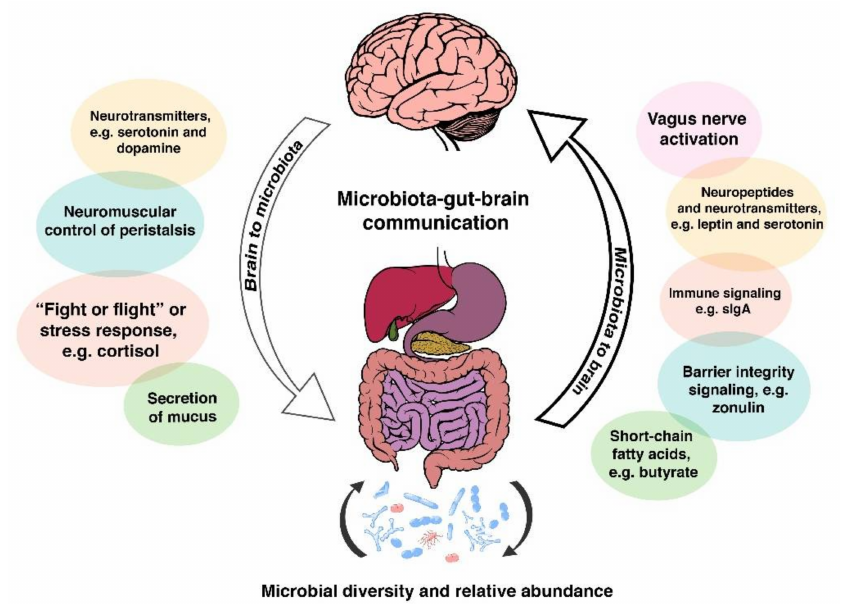
Figure 1. A simplified diagrammatic illustration of the bidirectional communication pathways between the gut microbiota and the brain, featuring a range of molecules originating in the gut that are involved in the upstream part of the communication system. Also featured is the “fight or flight” response, driven by the activation of the sympathetic nervous system, and how exposure of to that response plays an important role in the dysregulation of the intestinal